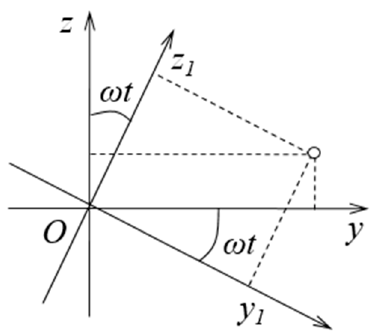
Figure 9. Coordinate rotation transformation in the tillage process.